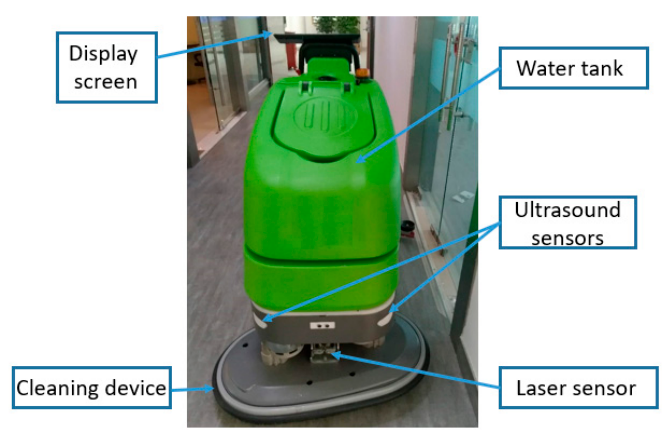
Figure 8. Front view of the cleaning vehicle.